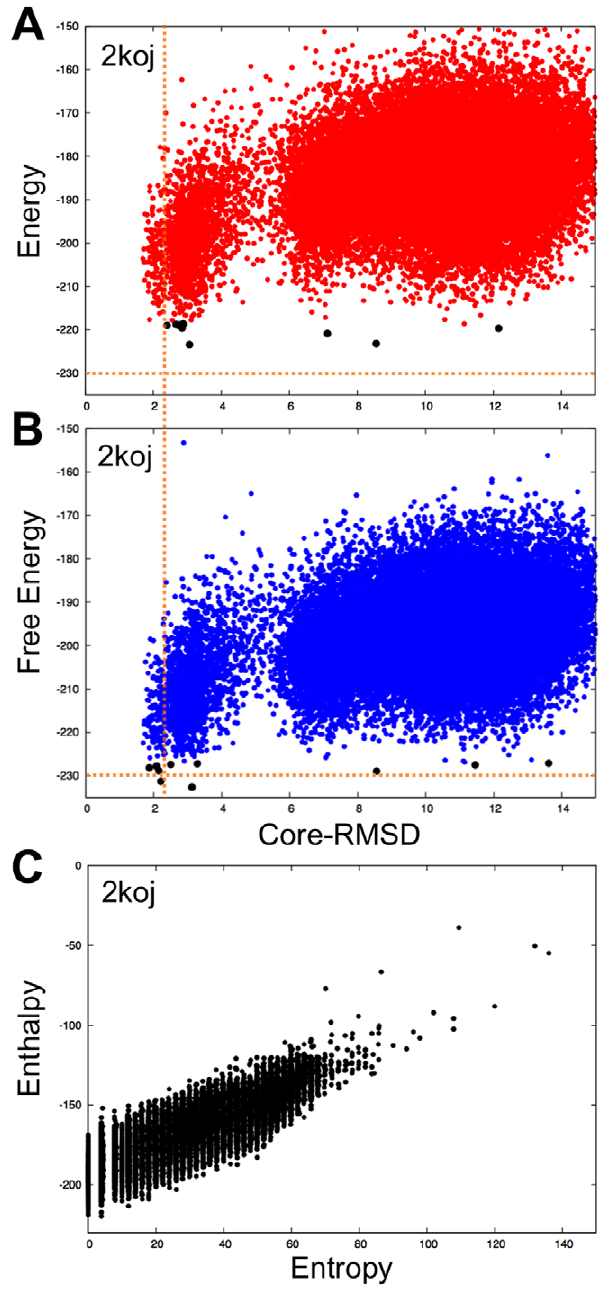
Figure 4. Comparison of energy versus rmsd and free energy versus rmsd plots for case with disordered internal loop (2k0J). A) Rosetta all atom energy and B) free energy computed using Eq. (1) with predicted disordered regions (Fig 3B-2k0j). The energy shown in A is calculated using the Rosetta all-atom energy. In A and B, the x-axis is the RMSD to thefolded portion of the nativestructure. The10 lowest energy/ free energy decoys are shown in black. The dashed orange lines are provided to aidcomparison of thetwoplots.( C) . Compensation between the entropic and energetic contributions to the free energy (Eq. (1)). doi:10.1371/journal.pone.0022060.g004 predictions are similar or slightly worse (Figure 3 A). Figure 3 B shows examples of good predictions of disordered regions. We next compared the free-energy landscapes computed using Eq. (1) with predicted order/disordered assignments to standard